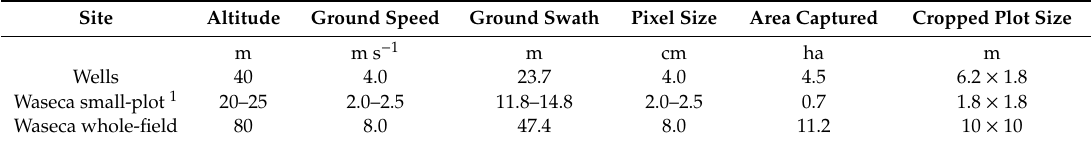
Table 2. Spatial description of aerial image campaigns at each experimental site. The cropped plot size refers to the spatial extent of cropped image at each sample location. Site Altitude Ground Speed Ground Swath Pixel Size Area